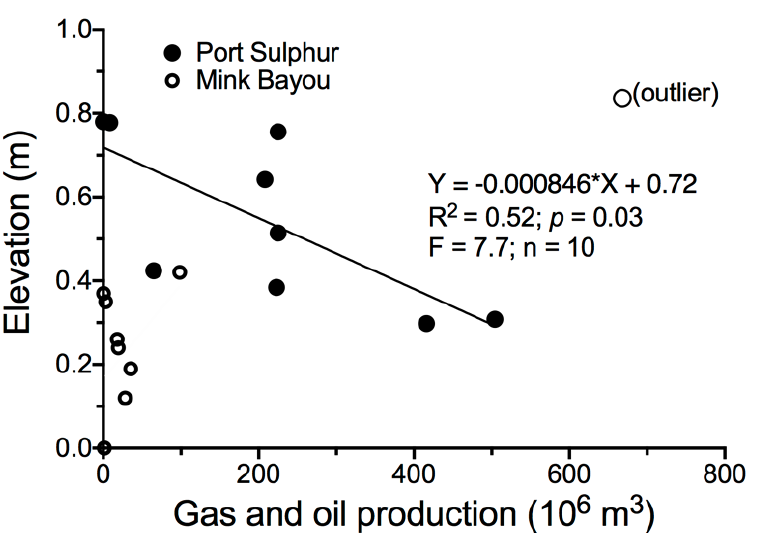
Figure 4. Gas and oil production (million m 3 ) and elevation (m) between 75 to 125 m distance from the waterway. The data point at 0 m elevation is the average at all dry well locations. The regression line is based on data from Port Sulphur.